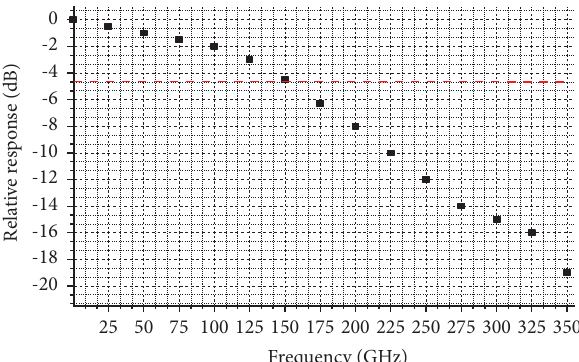
Figure 4: Frequency measurements as a function of relative